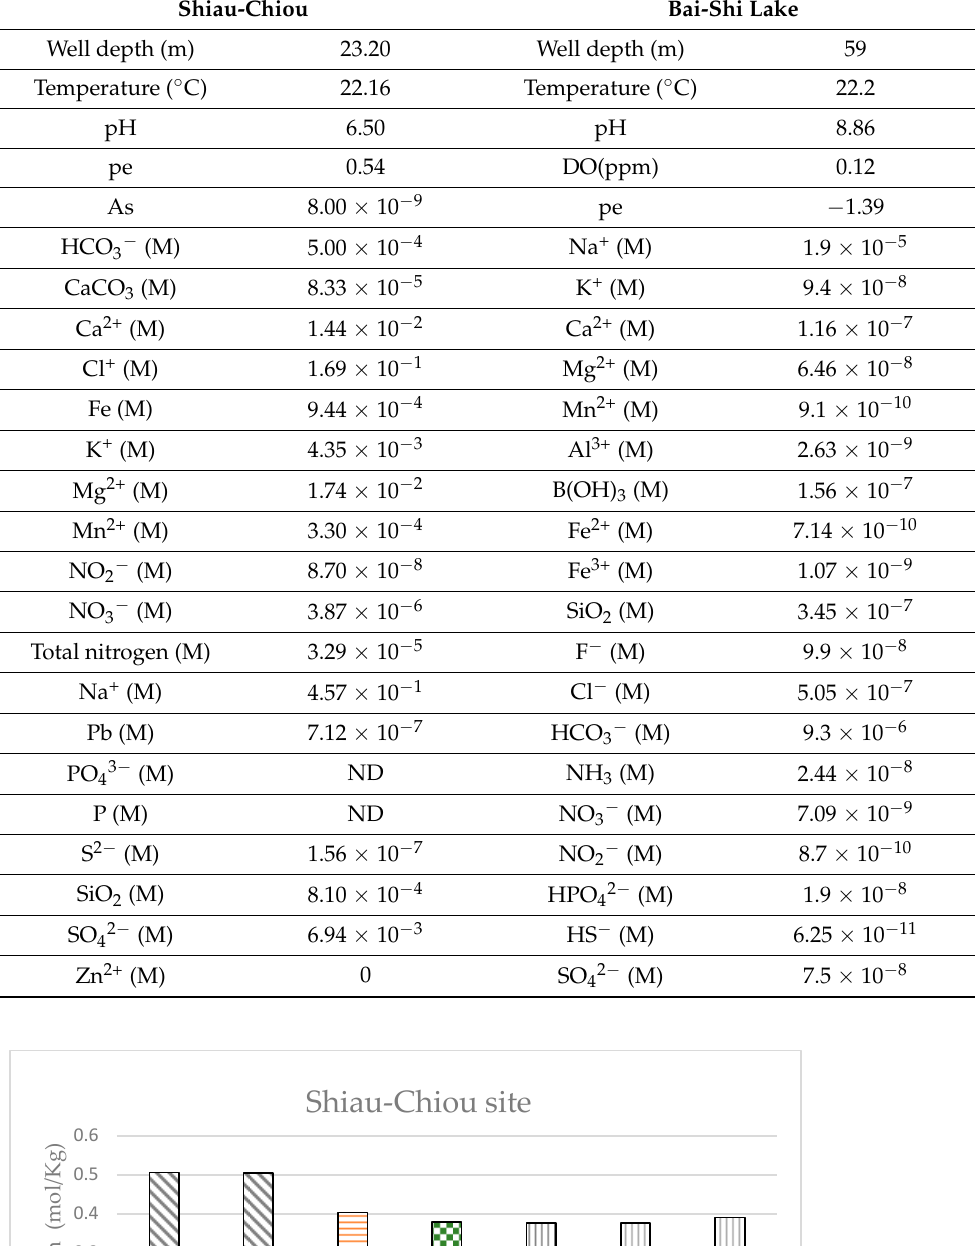
Table 11. Groundwater quality of Shiau-Chiou, Kinmen County, and Bai-Shi Lake, Hsinchu County.